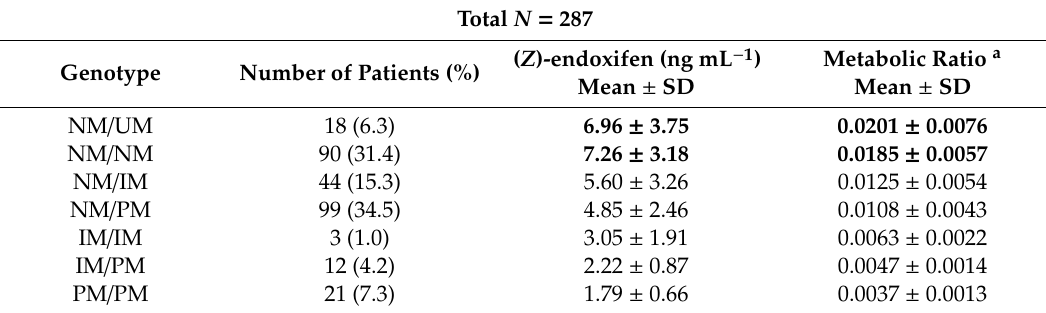
Table 1. CYP2D6 genotype frequency, steady-state plasma concentration, and metabolic ratio (MR) of ( Z